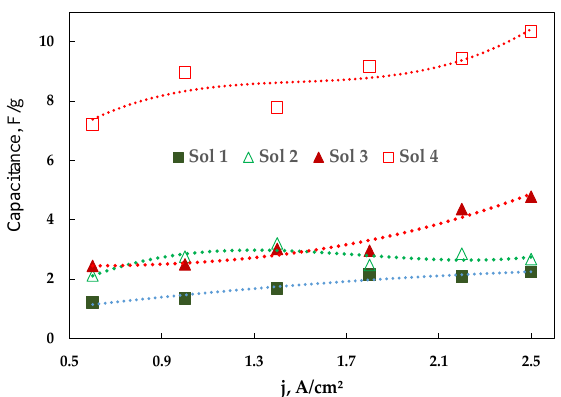
Figure 8. Influence of cathodic current density on the capacitance per gram of cobalt foams in the investigated solutions.